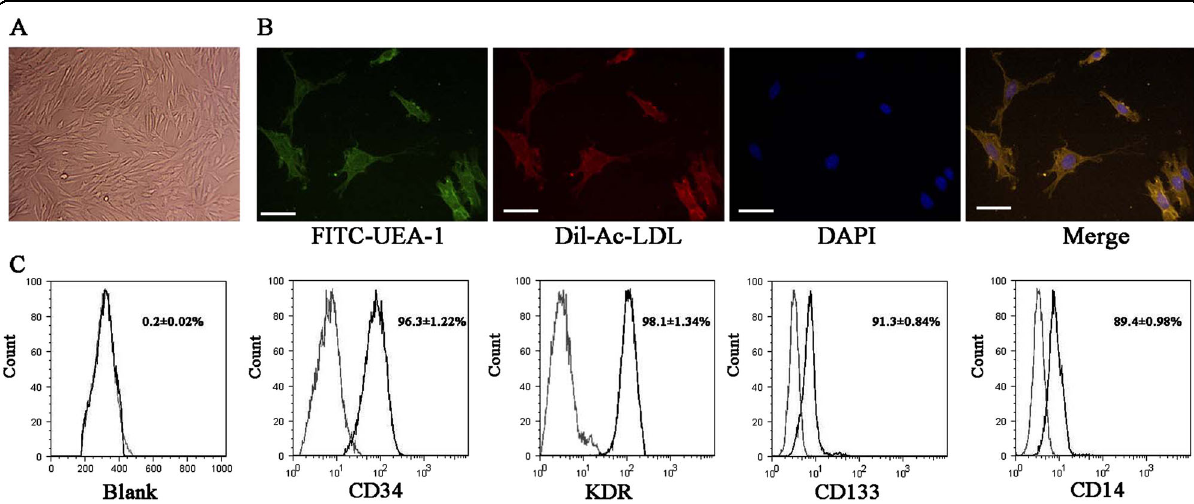
Fig. 1 Characterization of endothelial progenitor cells (EPCs) by confocal microscopy and fl ow cytometric analysis. a EPCs have a typical cobblestone-like morphology. b EPCs were stained with FITC-labeled or DiI-labeled UEA-1 and Ac-LDL and then detected using a confocal microscope. Scale bar, 20 μ m. c Flow cytometric analysis of EPC surface markers (CD34, KDR, CD133, and CD14). The results presented are typical of those obtained from three separate